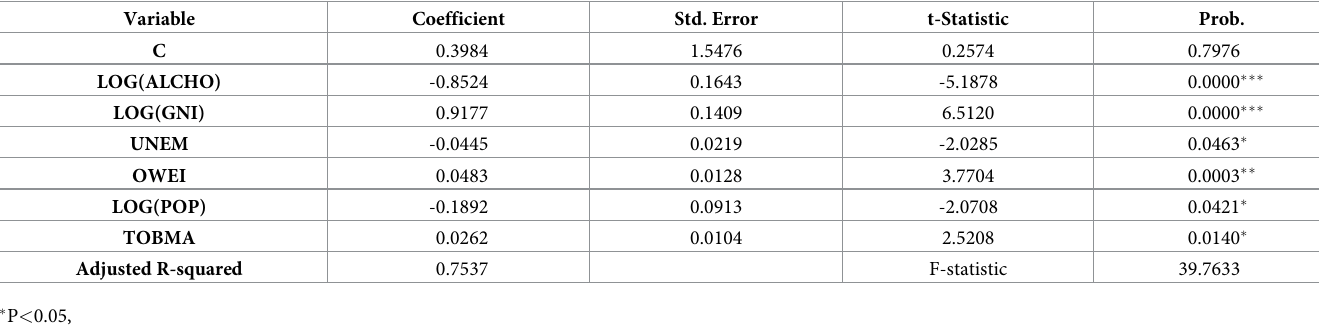
Table 6. Model 2A results: Low volatility